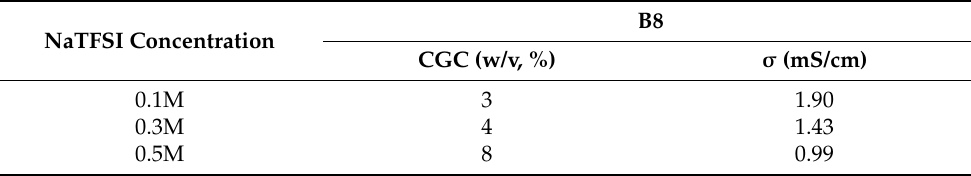
Table 1. CGCs of B8 required to gel the BMPTFSI solution of different NaTFSI concentrations, and the corresponding conductivity of gel ( σ